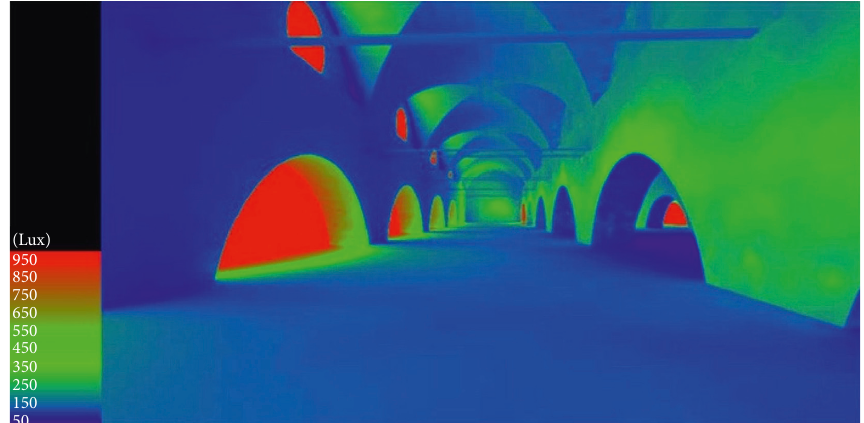
Figure 9: Natural daylight simulation, summer solstice. 3D illuminance representation (lx). Nave 1, Atarazanas , Seville,